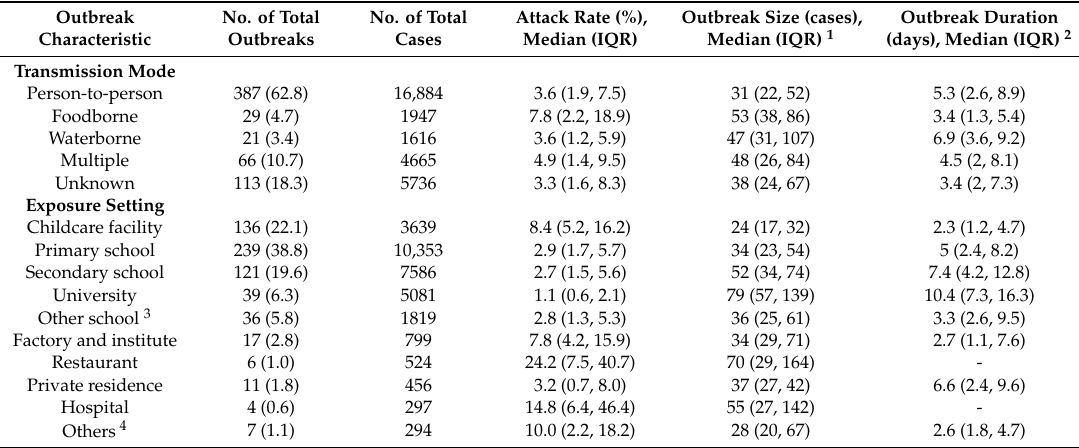
Table 3. Number of reported norovirus outbreaks and outbreak-associated indicators by transmission mode and setting in China,